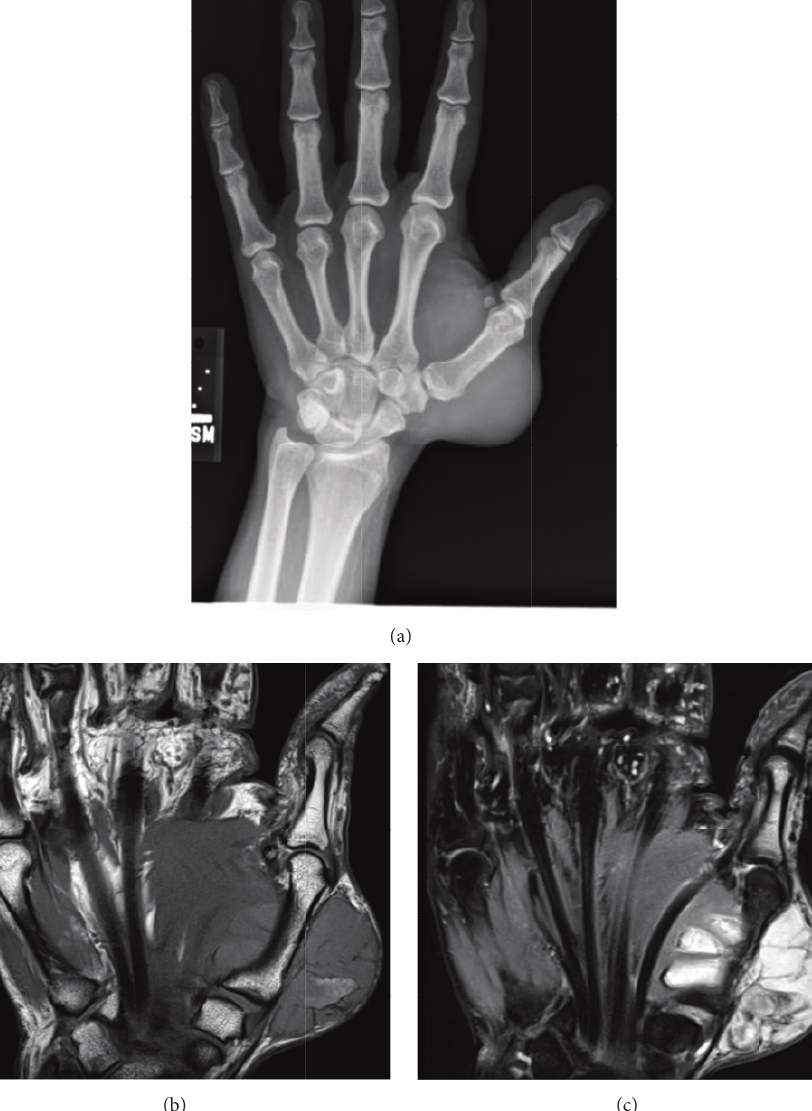
Figure 6: Preoperative imaging. (a) X-rays demonstrating a soft tissue mass with some underlying bony erosion of the first metacarpal. (b) Coronal T1-weighted MRI of the left hand demonstrating envelopment of the first metacarpal. (c) Coronal T2-weighted MRI of the left hand demonstrating involvement of the first